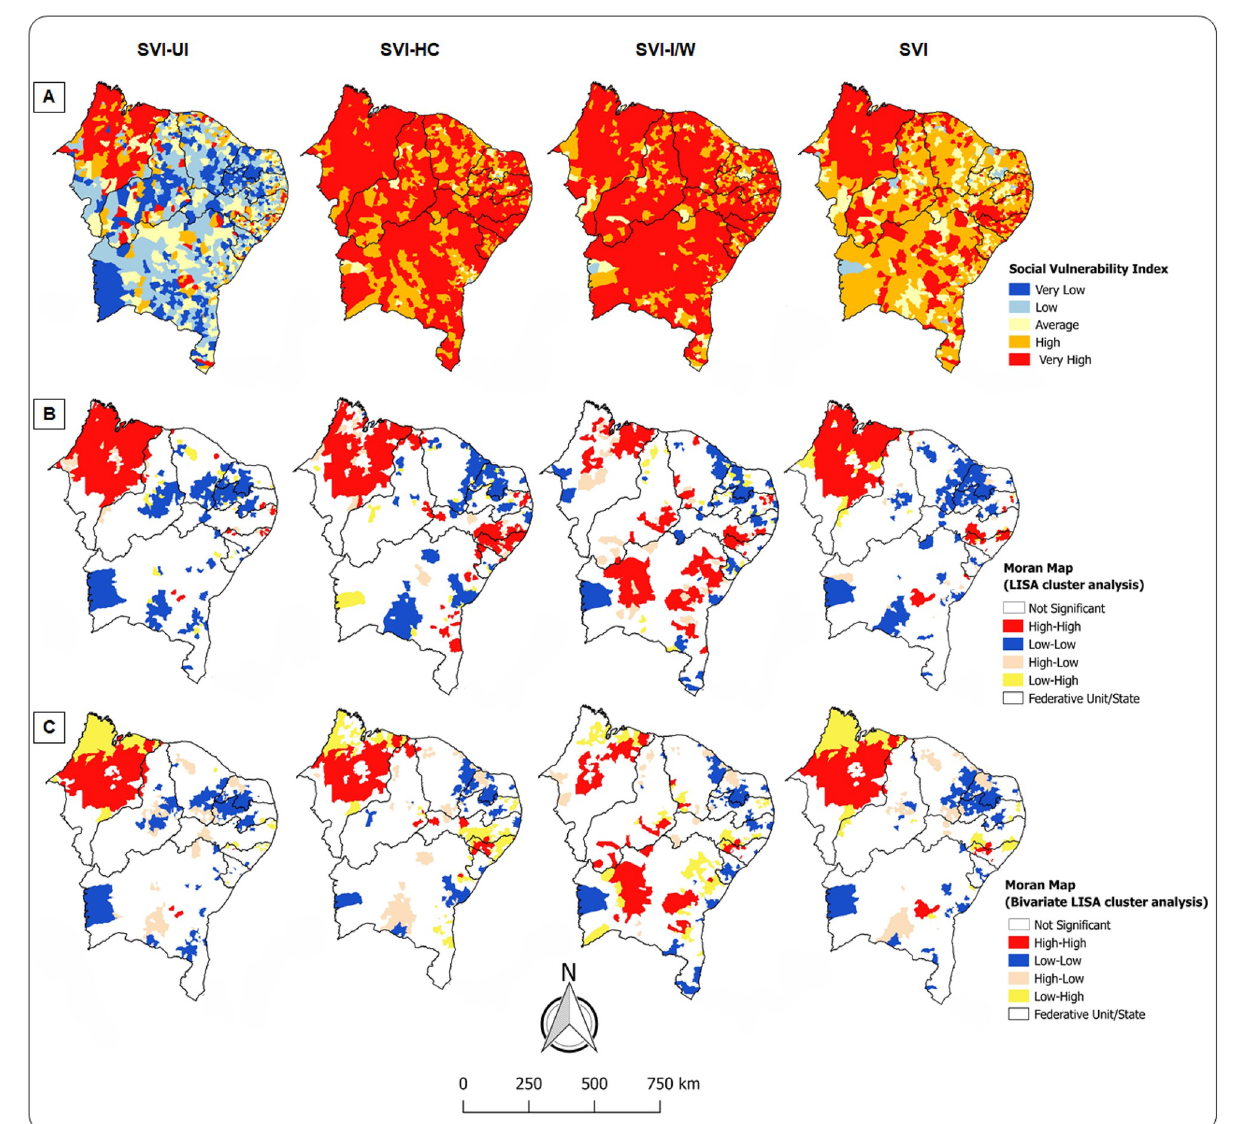
Fig 4. Association between VL transmission and social vulnerability, Northeast, Brazil (2000–2017). (A) Spatial distribution of SVI. (B) Univariate LISA cluster analysis of SVI. (C) Bivariate LISA cluster analysis of VL incidence rate and